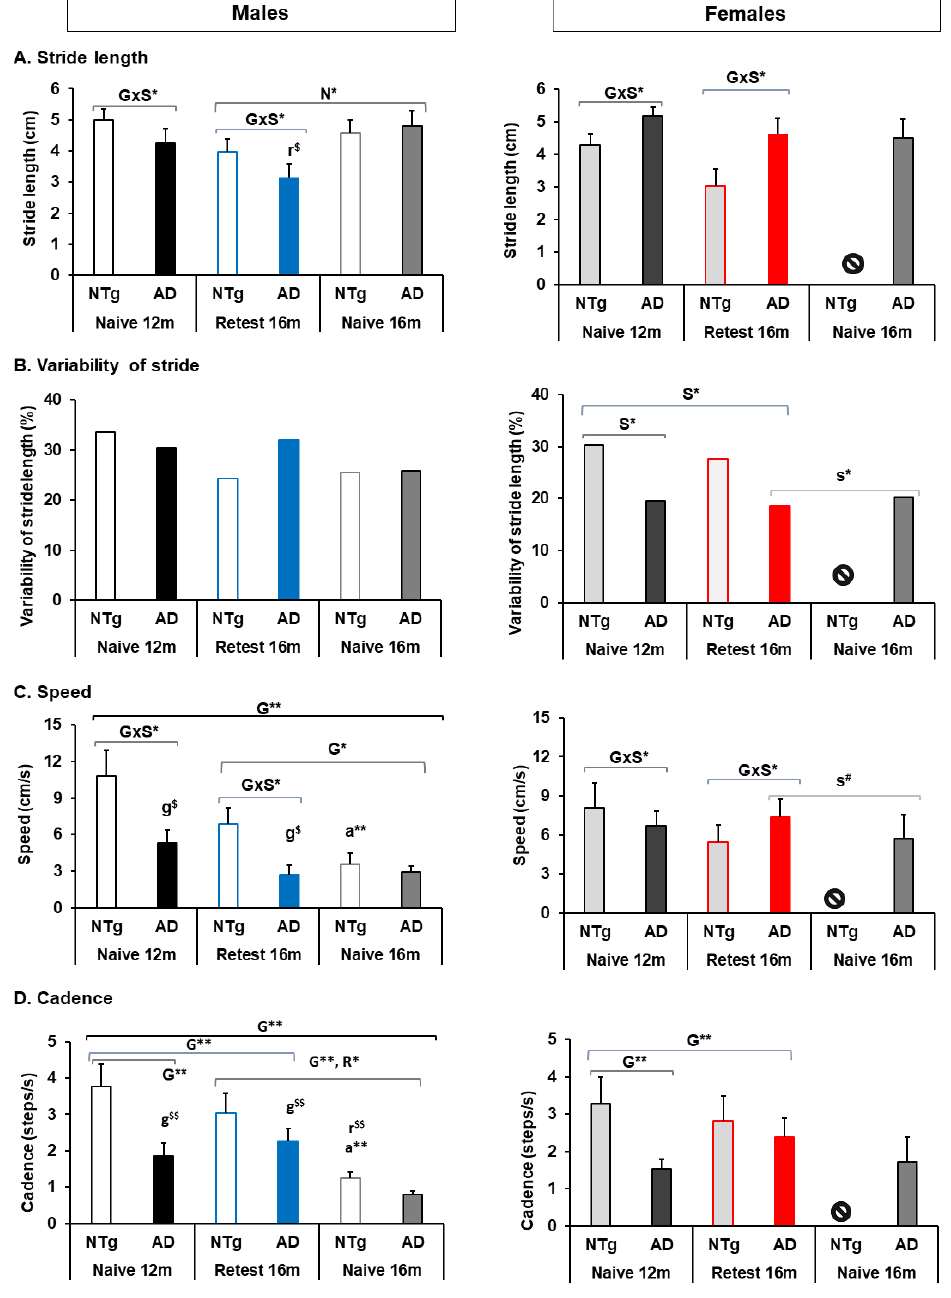
Figure 3. Quantitative parameters of gait. ( A ) Stride length, ( B ) variability of stride, ( C ) speed, ( D ) cadence. Statistics: ANOVA, G, genotype effect, G** p < 0.01**, G* p < 0.05*. S, sex effect, S* p < 0.05*. G×S, genotype and sex interaction effects, G×S* p < 0.05*. R, re-test effect, R* p < 0.05*. N, naïve effect, N* p < 0.05*. a, aging, a** p < 0.01**. Bonferroni post hoc test: g, genotype; s, sex; $ expressed genotype differences between sex, and # expressed sex differences between genotypes. The symbol ⦸ indicates the absence of the group, and m, months.